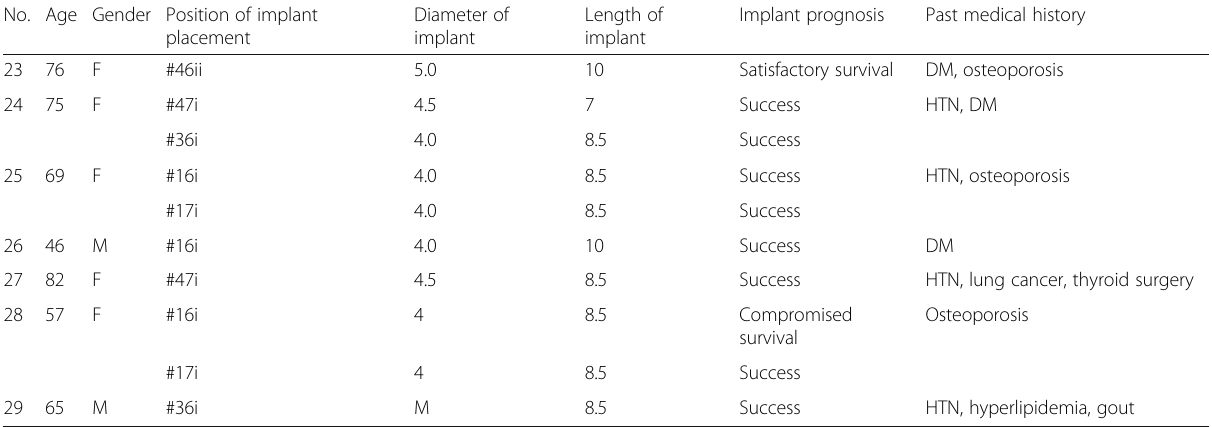
Table 1 Details of medically compromised patients (Continued) No. Age Gender Position of implant placement